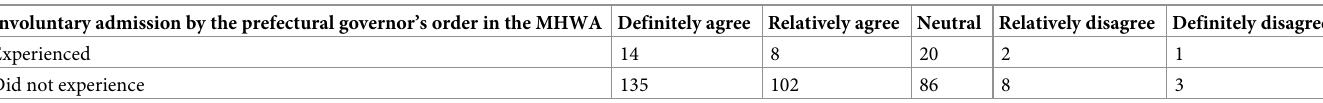
Table 1. Opinion of involuntary admission by the prefectural governor’s order (Split by whether or not involuntary admission by the prefectural governor’s order was experienced). What is your opinion of the scheme of involuntary hospitalization by the prefectural governor’s order for patients at risk of harm to self or others because of mental disorders? Involuntary admission by the prefectural governor’s order in the MHWA Definitely agree Relatively agree Neutral Relatively disagree Definitely disagree